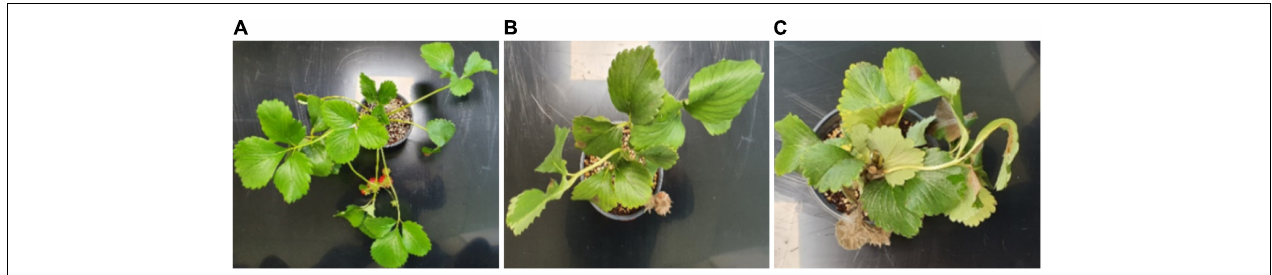
FIGURE 2 | Onset of disease after gray mold disease inoculation [ (A) healthy state before inoculation, (B) moderate stage 2 days after inoculation, (C) severe stage 4 days after inoculation].